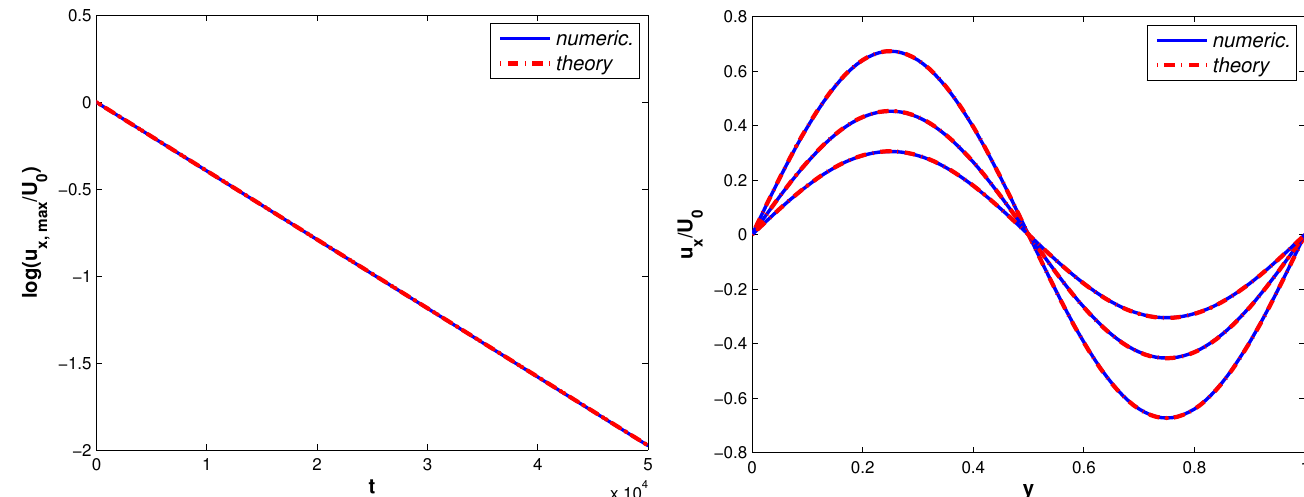
Figure 2. Shear wave decay. The logarithm of the peak velocity time histories obtained numerically and analytically are presented ( first slide ); velocity profiles at different moments of time ( t = 10 5 , t = 2 × 10 5 , t = 3 × 10 5 ) obtained numerically and analytically are presented ( second slide ), the spatial variable y is normalized on the domain length L